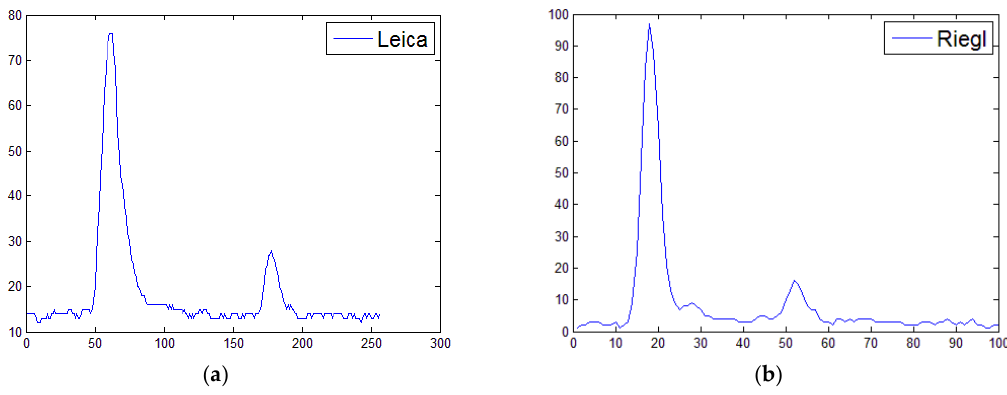
Figure 9. The different waveforms in this study: ( a ) a waveform with 256 samples from case 1; ( b ) a waveform with 100 samples from case 4.